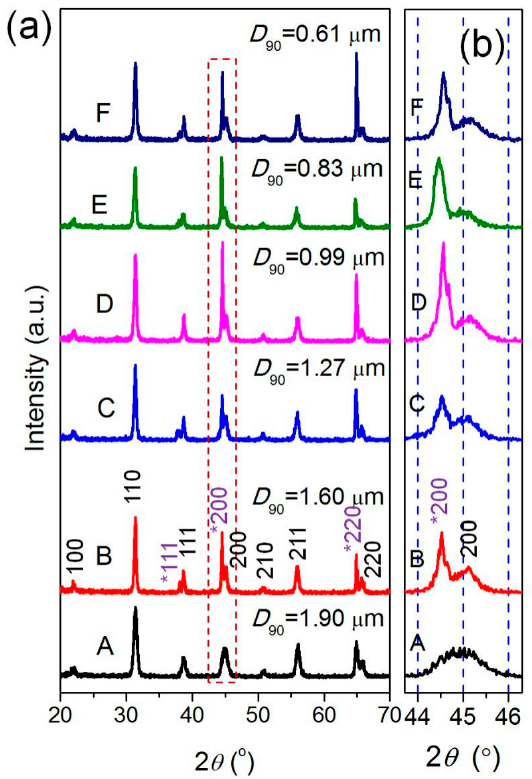
Figure 6. ( a ) XRD patterns of the BPA films obtained via Route 2 using BT powders with various particle sizes as the functional inorganic filler ( M BT / M polymer = 4); ( b ) the partial enlarged XRD patterns in the 2 θ range of 45-46 ° .